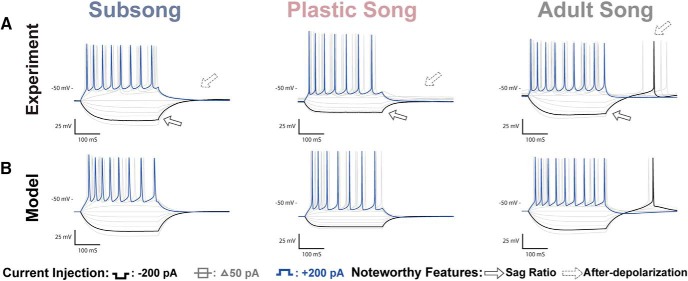
HVCX recordings and coresponding model traces. A, Voltage traces of HVCX neurons recorded at subsong, plastic song, or adult stages of development. Features that showed developmental changes included an increase in the Sag ratio (solid arrow) and an increase in rebound depolarization that resulted in rebound spiking (dotted arrow). B, Model traces of the three neurons depicted in A. The models attribute the sag to the h-current and rebound firing to the T-type Ca2+ current.